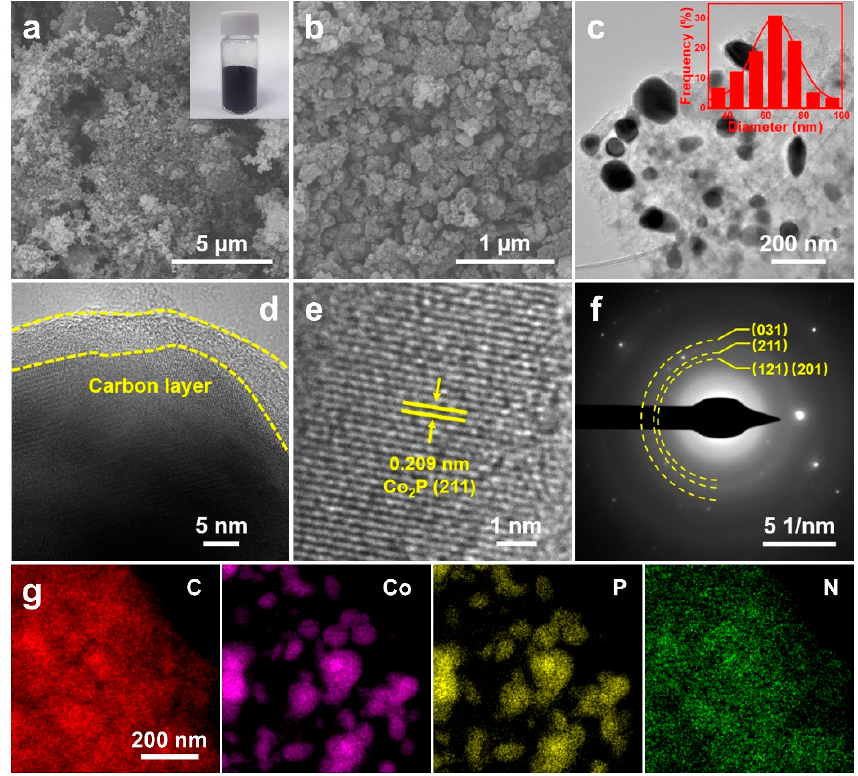
Figure 2. The morphology and structure of the Co 2 P@N-C-900. ( a , b ) SEM images (inset digital photo shows the production of Co 2 P@N-C-900 in the gram scale), ( c ) TEM (inset shows particle size distribution of Co 2 P@N-C-900) and ( d , e ) HR-TEM images, ( f ) SAED pattern, and ( g ) elemental mapping images of Co 2 P@N-C-900.